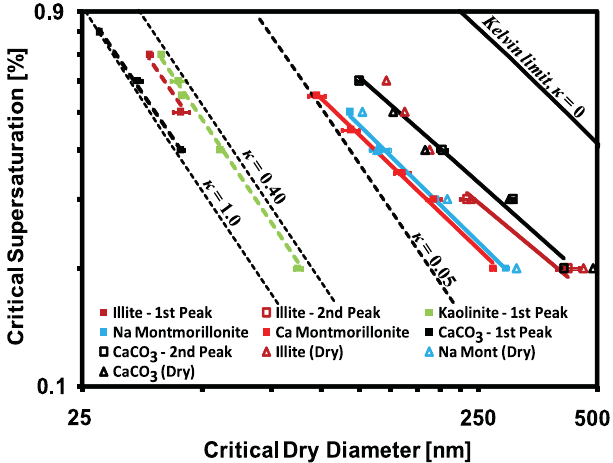
Fig. 4. CCN activation curves for different mineral and clays types considered in this study. Solid and open square ( (cid:4) , (cid:3) ) symbols refer to wet generated CCN activity and dashed lines show κ -KT fits. Open triangle ( 1 ) refers to dry generated CCN activity and solid lines are FHH adsorption activation fits (obtained from Kumar et al.,